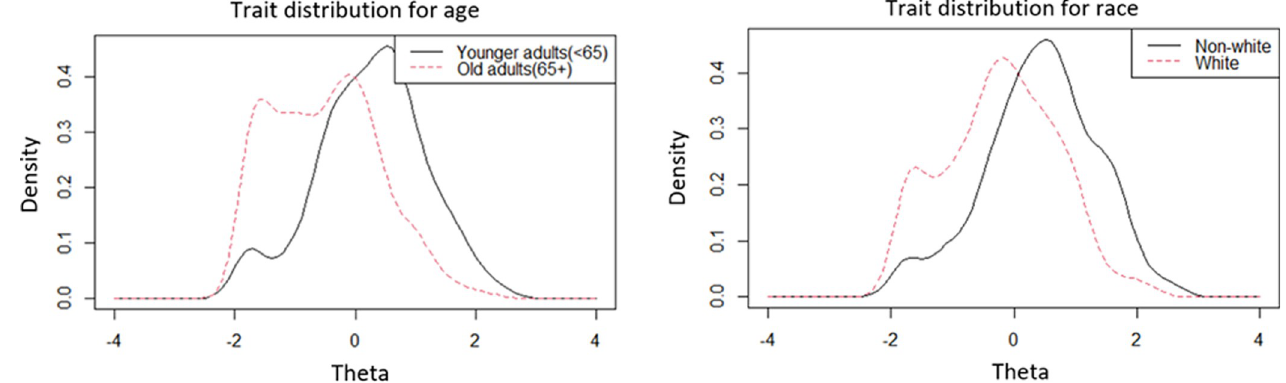
Fig 1. Trait distributions for age and